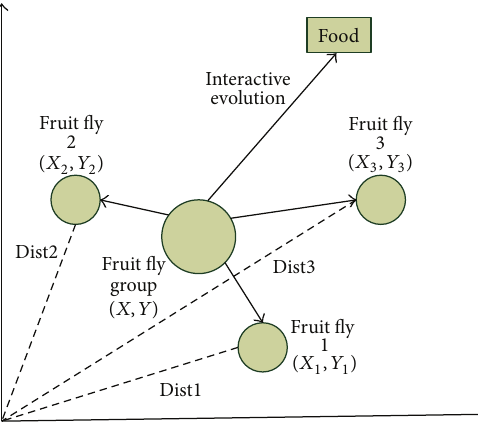
Figure 2: Food finding iterative process of a fruit fly